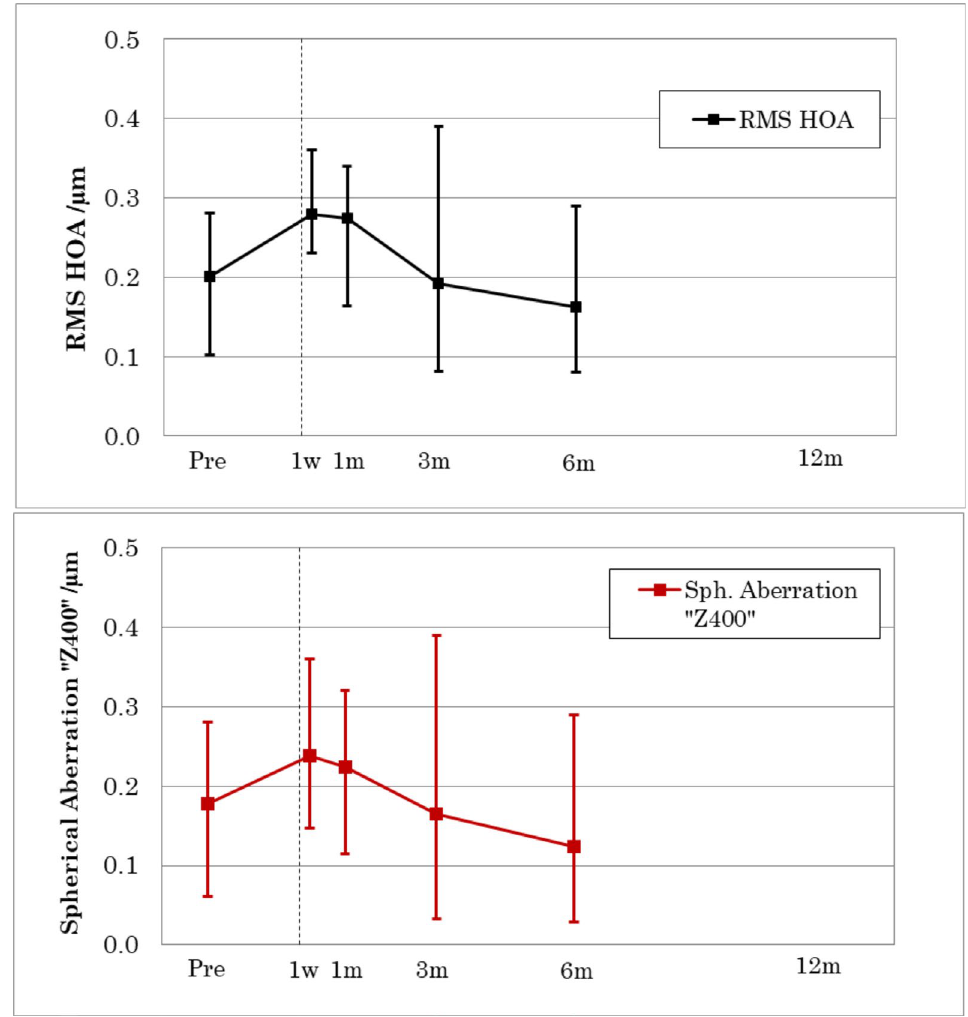
Figure 7. Change of HOA RMS ( top ) and spherical aberration ( bottom ) up to six-month follow-up. Data points represent mean values for all five eyes. Error bars indicate min and max observed values.